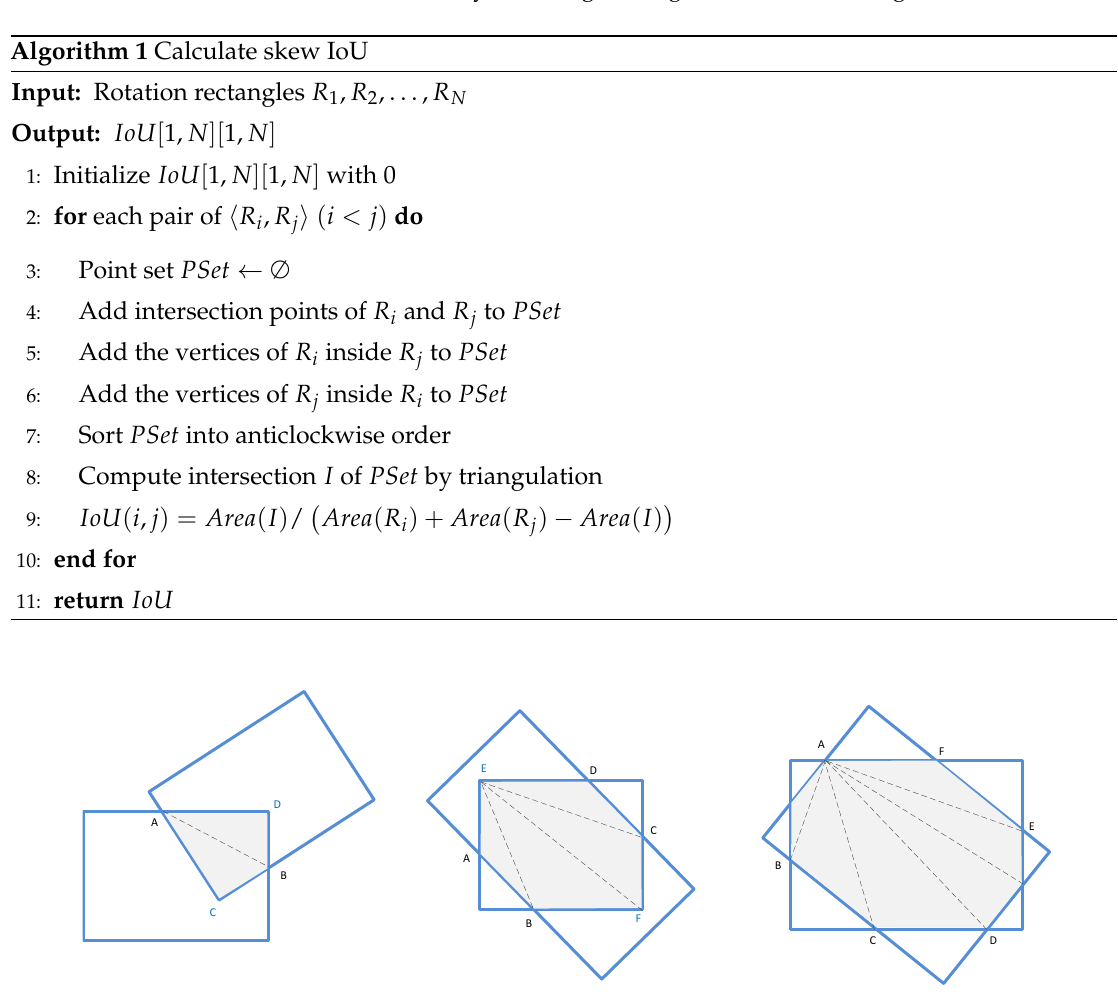
Figure 6. Examples of compute skew IoU. Intersection points are marked in black, and vertices inside the other rectangle are marked in dark